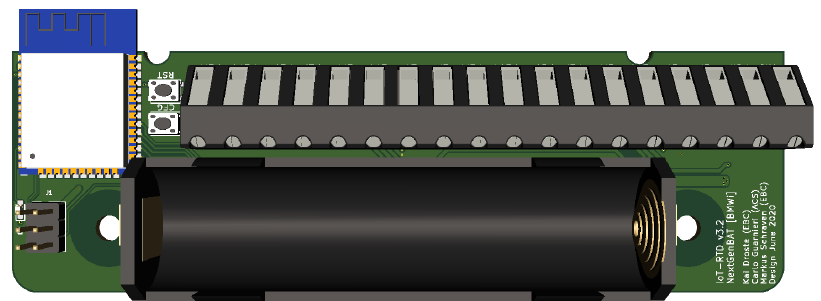
Figure 2. View of the temperature gateway (TGW) PCB.